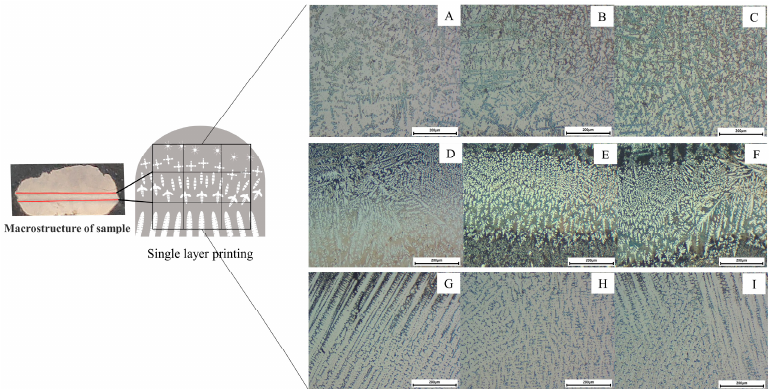
Figure 4. Optical microscopy characterization of single-layer samples. ( A – C ) Top equiaxed crystal zone. ( D – F ) Middle secondary phase mixing zone. ( G – I ) Bottom columnar crystal zone.